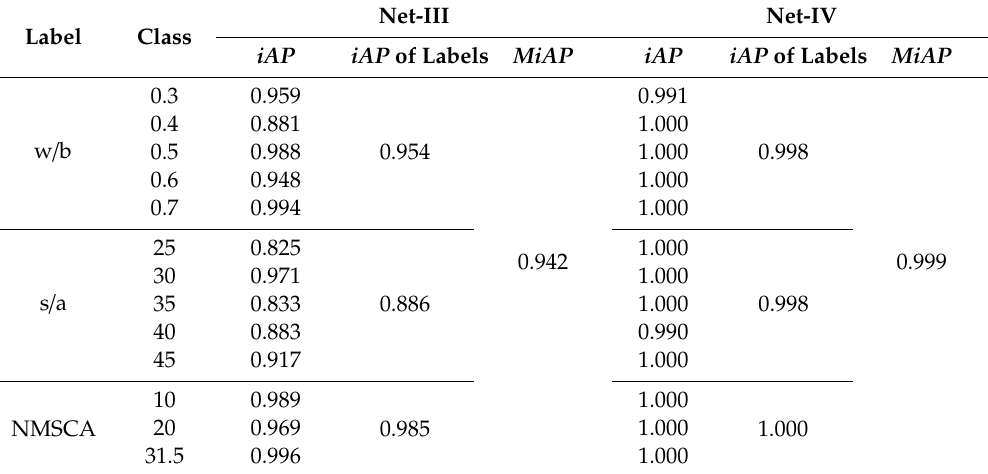
Figure 6. P – R curves of: ( a ) classes in w/b label of Net- Ⅲ; ( b ) classes in s/a label of Net- Ⅲ; ( c ) classes Figure 6. P–R curves of: ( a ) classes in w / b label of Net-III; ( b ) classes in s / a label of Net-III; ( c ) classes in in NMSCA label of Net- Ⅲ; ( d ) classes in w/b label of Net- Ⅳ; ( e ) classes in s/a label of Net- Ⅳ; ( f ) NMSCA label of Net-III; ( d ) classes in w / b label of Net-IV; ( e ) classes in s / a label of Net-IV; ( f ) classes in classes in NMSCA label of Net- Ⅳ. NMSCA label of Net-IV. Table 15. (cid:2169)(cid:2191)(cid:2157)(cid:2172) and (cid:2191)(cid:2157)(cid:2172) of each class and label. Table 15. MiAP and iAP of each class and